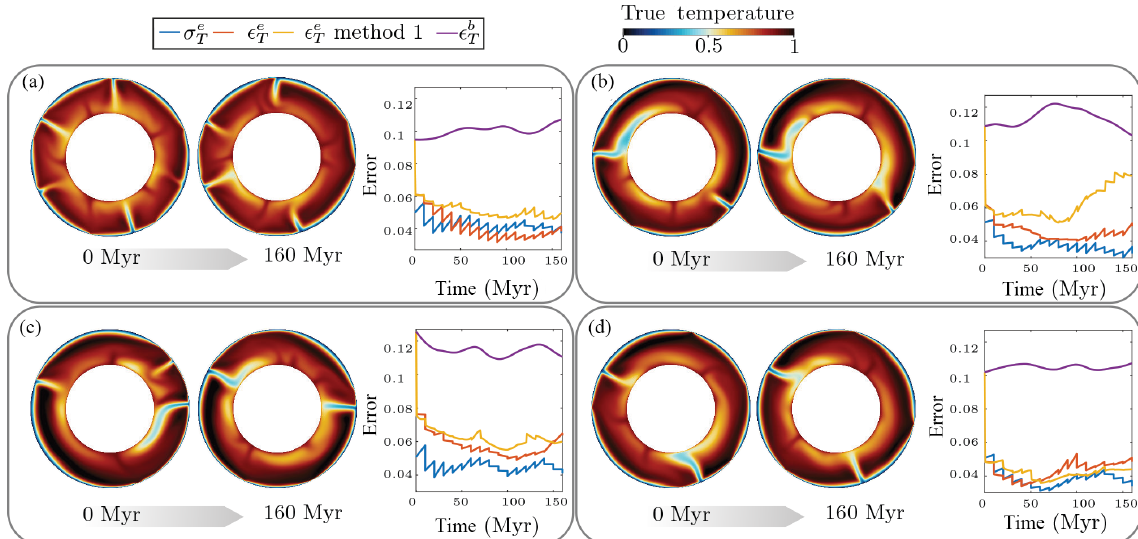
Figure 3. Evolution of the error ( (cid:15) e , red) as a function of time for four different evolutions with N = 288, γ + = 1 . 25, (cid:96) v = 0 . 7 and (cid:96) h = T π/ 10, compared to the evolution of the spread of the ensemble ( σ e , blue), the evolution of the error with the technique of Bocher et al. (2016) T ( (cid:15) e method 1, yellow) and the background error ( (cid:15) b , purple). The initial and final states of the true evolutions are represented on the left of T T each corresponding